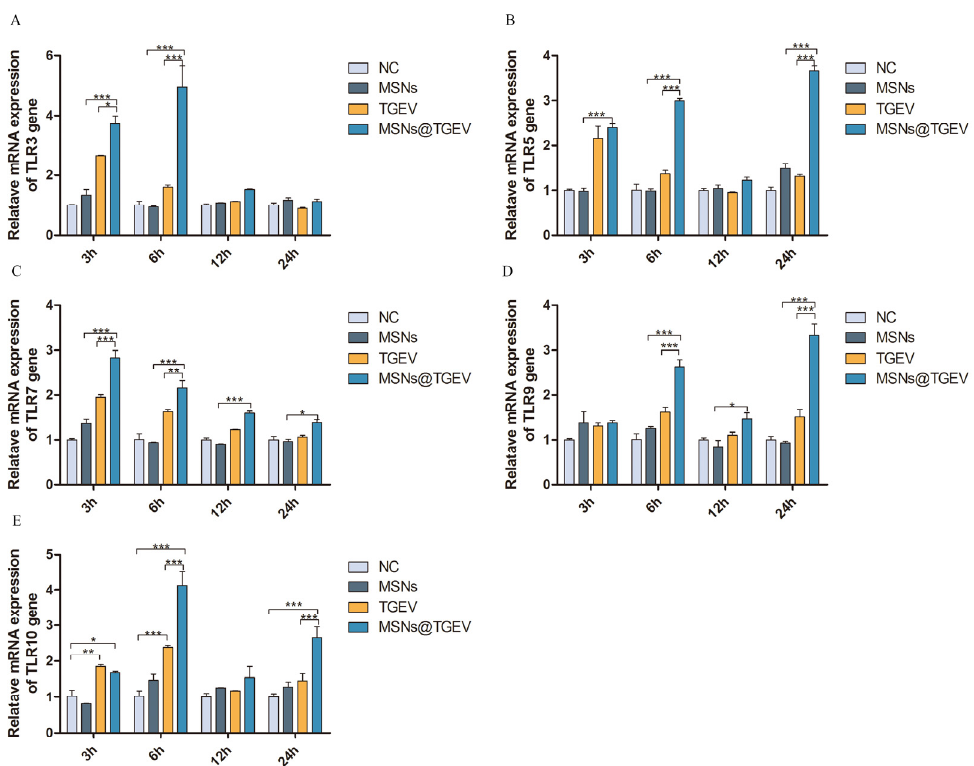
Figure 5. mRNA expression of TLRs on DCs after incubation with the inactivated TGEV vaccine with MSNs for different times. Im-DCs were cultured with MSNs, inactivated TGEV and inactivated TGEV vaccine with MSNs, and cells were harvested at 3 h, 6 h, 12 h, and 24 h, respectively. Im-DCs untreated were negative control. mRNA expressions of TLR1-10 were assessed by real-time PCR. ( A ) the expressions of TLR3; ( B ) the expressions of TLR5; ( C ) the expressions of TLR7; ( D ) the expressions of TLR9; ( E ) the expressions of TLR10. Data were presented as mean ± SD of three duplicate samples. Differences were considered significant at (*) p < 0.05, (**) p < 0.01, (***) p < 0.001.